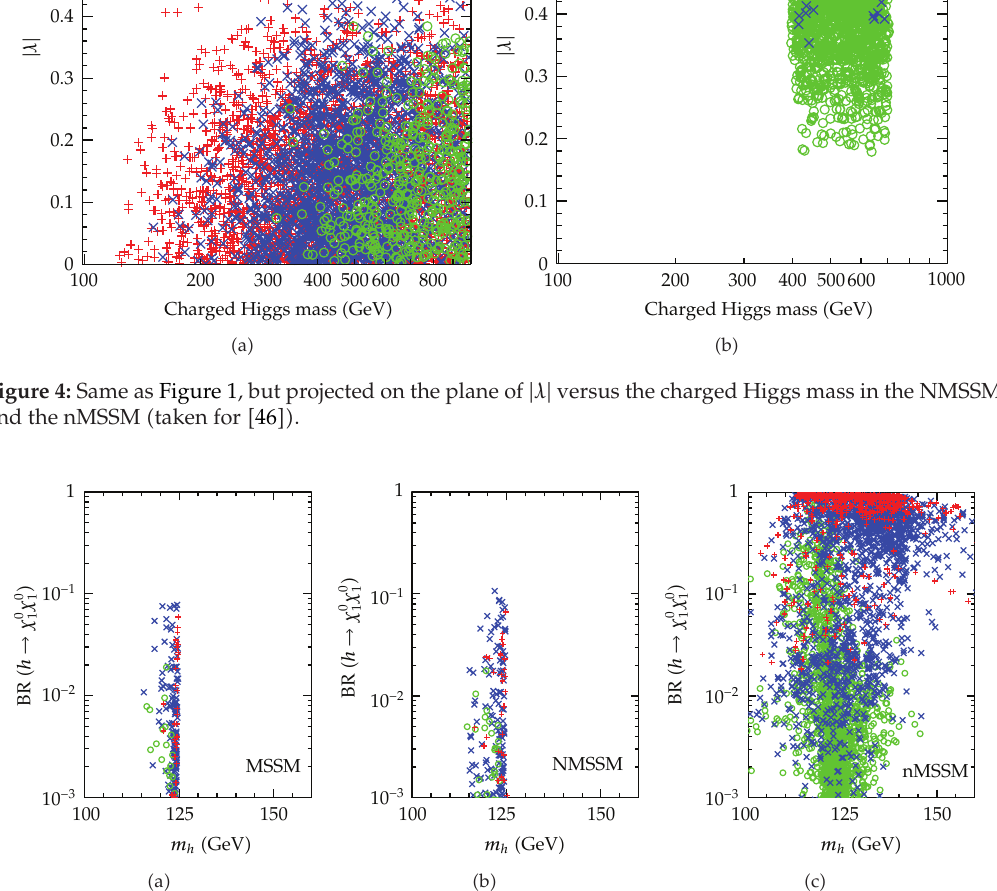
χ 0 versus the mass of 1 1